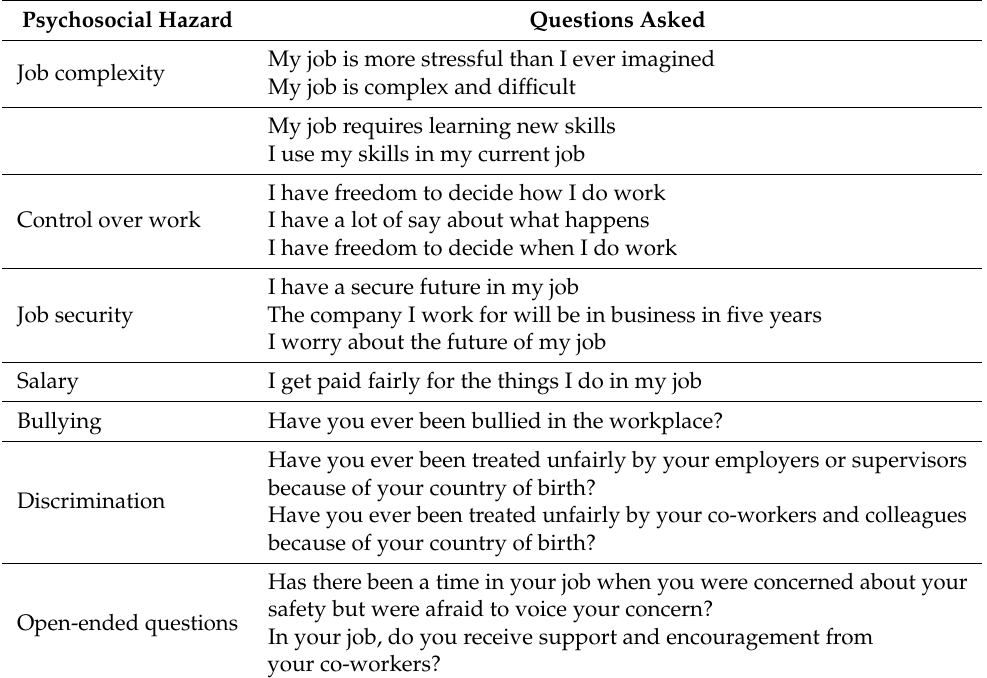
Table 1. Questions asked to determine workplace exposure to psychosocial hazards of working refugee participants (and used earlier in the cross-sectional